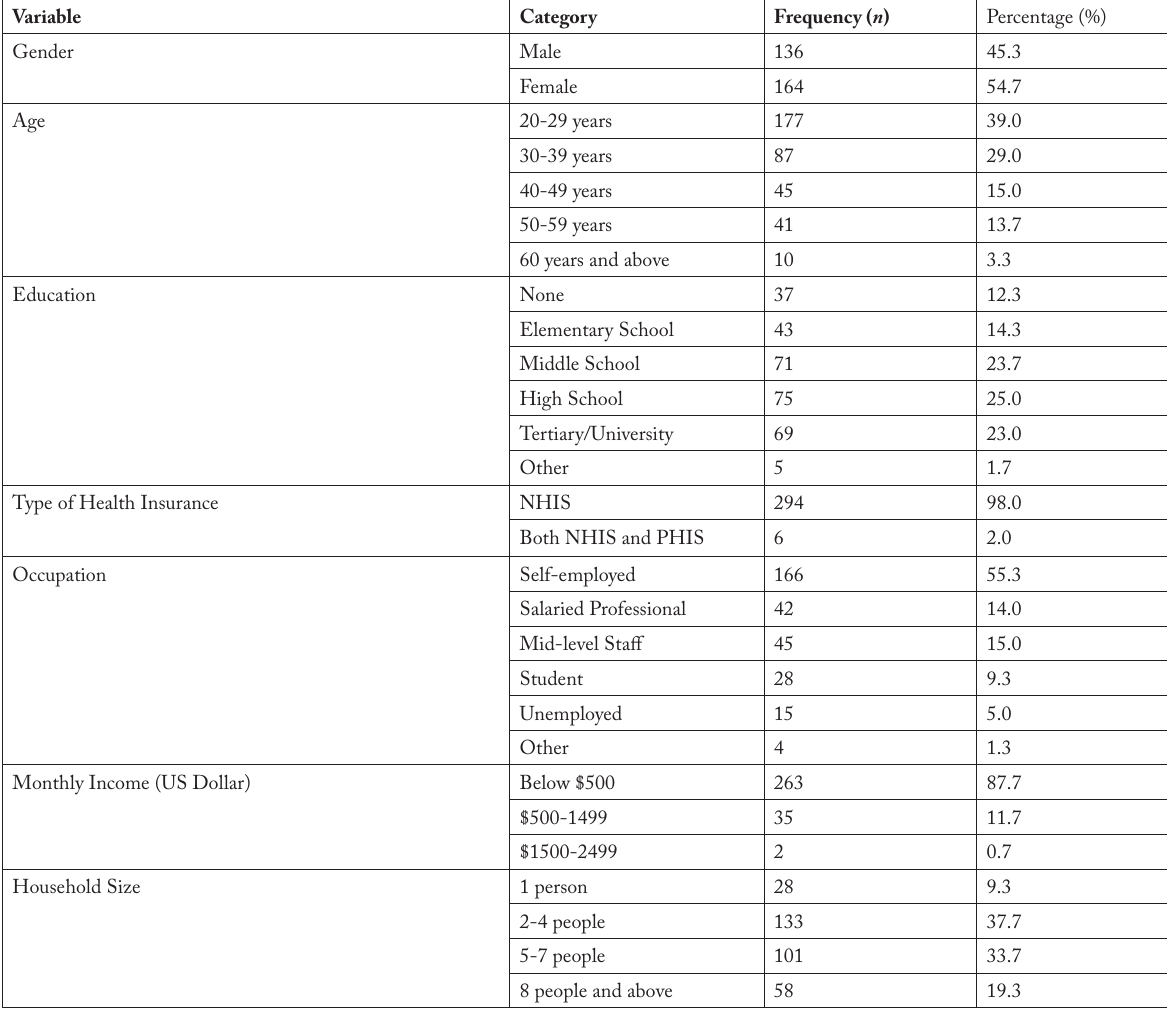
Table 2. Socio-demographic data of participants ( n = 300).